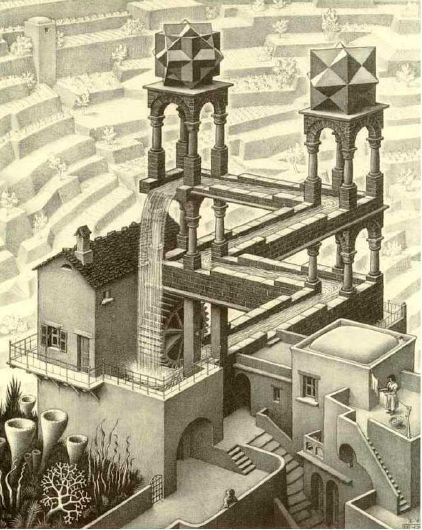
Figure 6: M.C. Escher’s “Waterfall”. ( © 2008 The M.C. Escher Company – the Netherlands [8]. All rights reserved. Used by